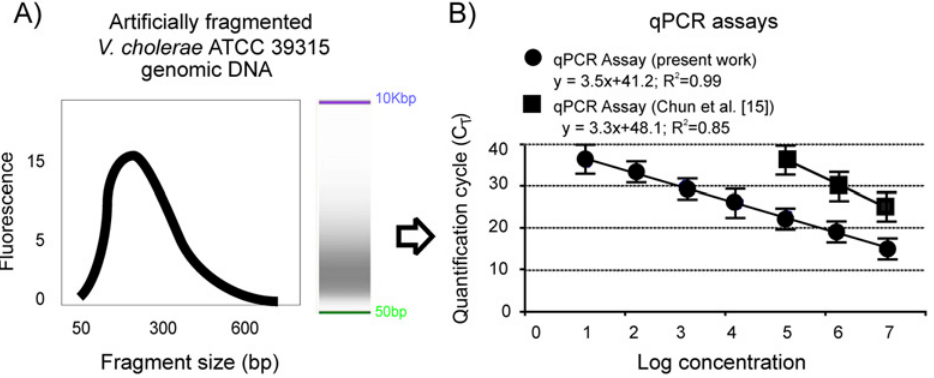
Fig 2. Performance of the qPCR assay for detection of V . cholerae in artificially degraded DNA samples. (A) Electropherogram plot obtained by Agilent Bioanalyzer analysis of artificially fragmented genomic DNA of V . cholerae ATCC 39315. (B) Plot of mean Cq-values from three replicates tested against the V . cholerae artificially fragmented DNA inputs. Error bars indicate the standard deviations of the